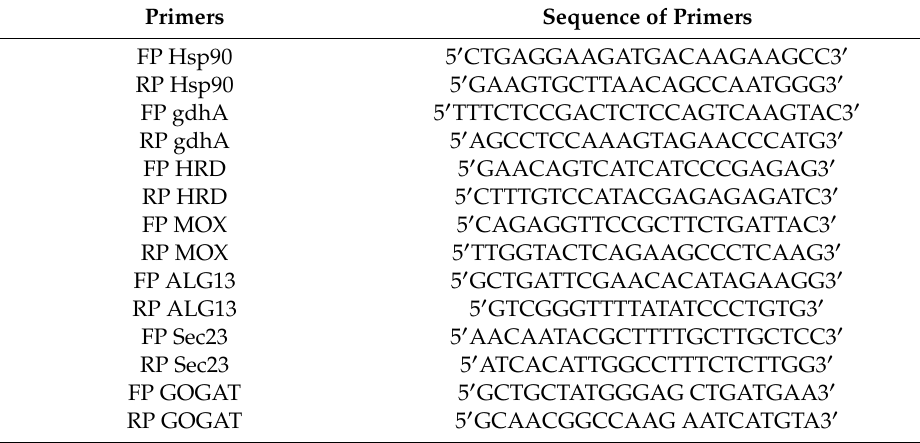
Table 1. List of primers used in studying transcript levels of some up- and down-regulated genes under optimized / unoptimized